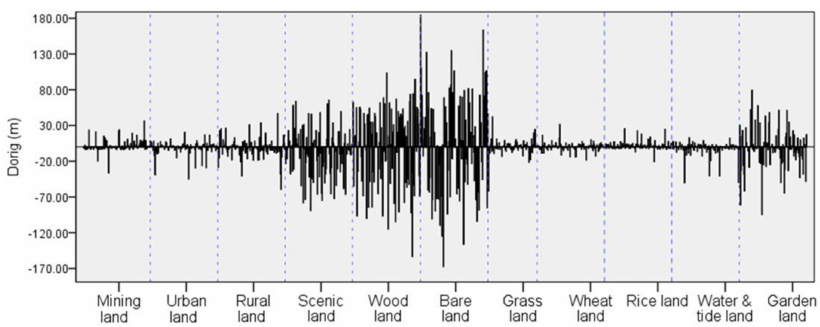
Figure 2. Land-use specific elevation differences ( Dorig ) between the original ASTER GDEM and the calibration data (the first sample set).